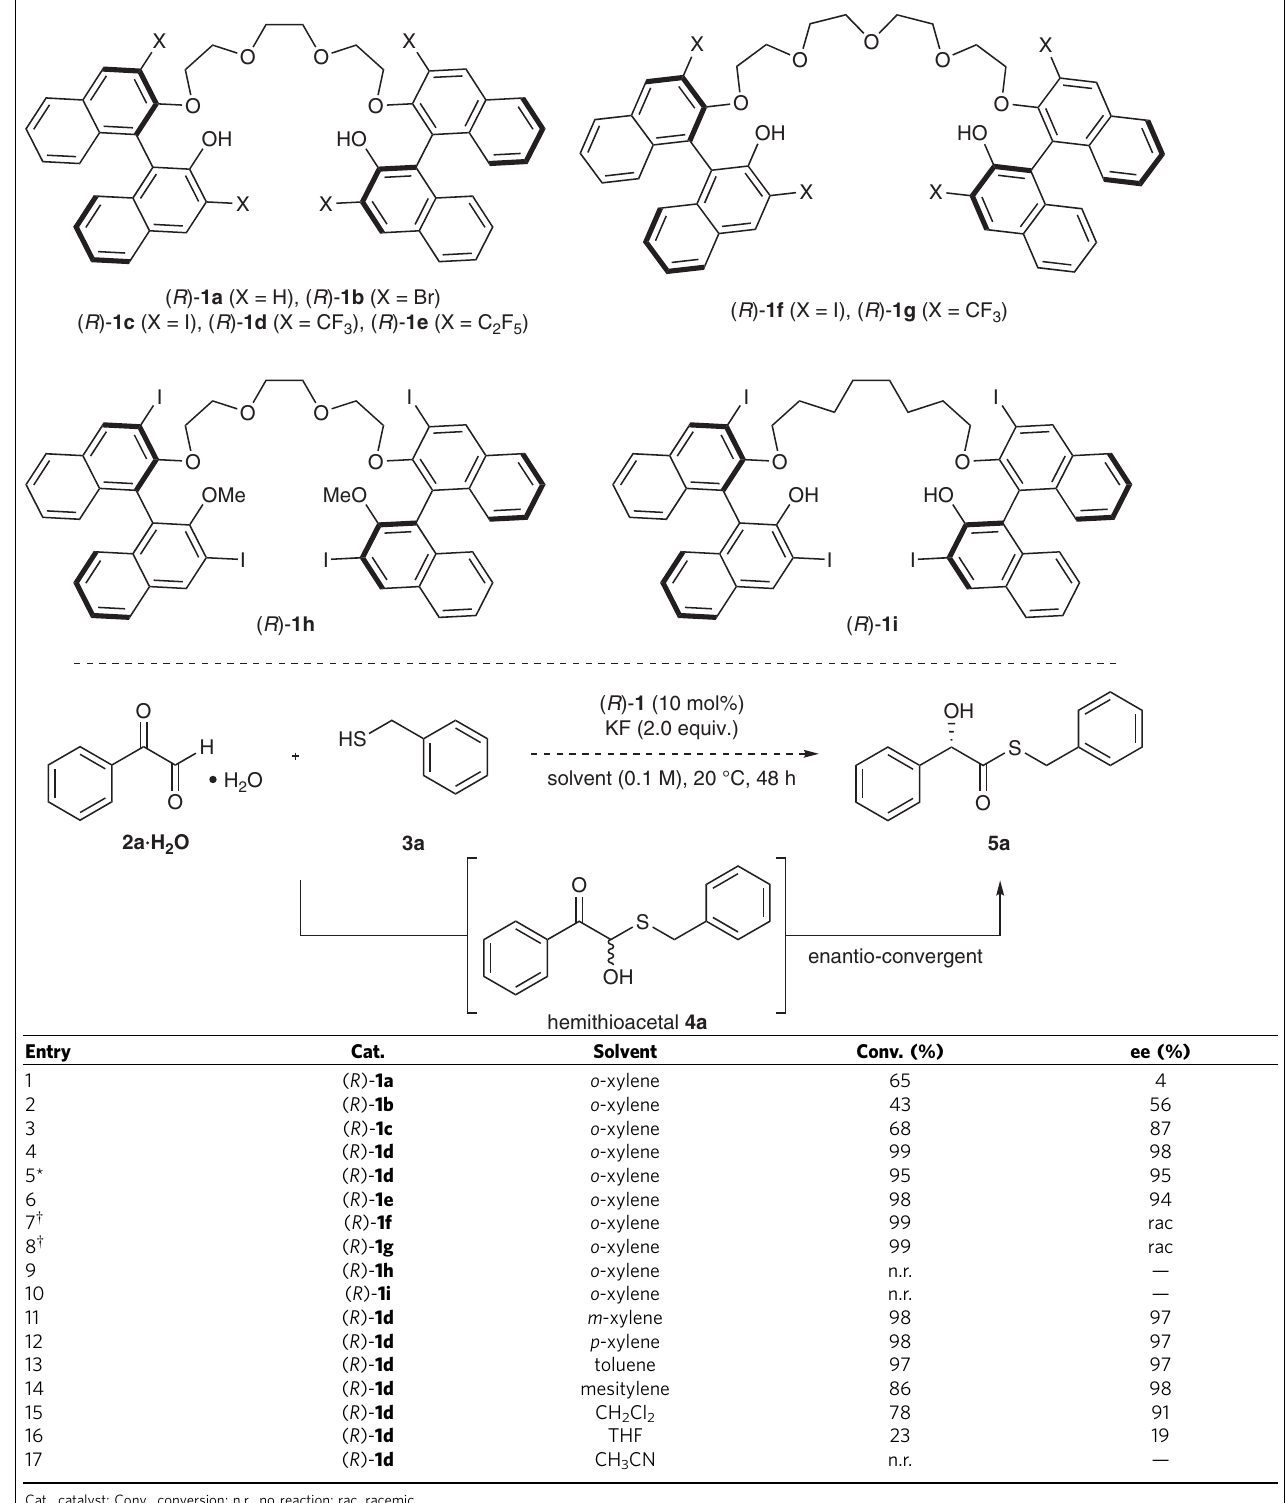
Table 1 | Optimization of the reaction conditions for the asymmetric isomerization of